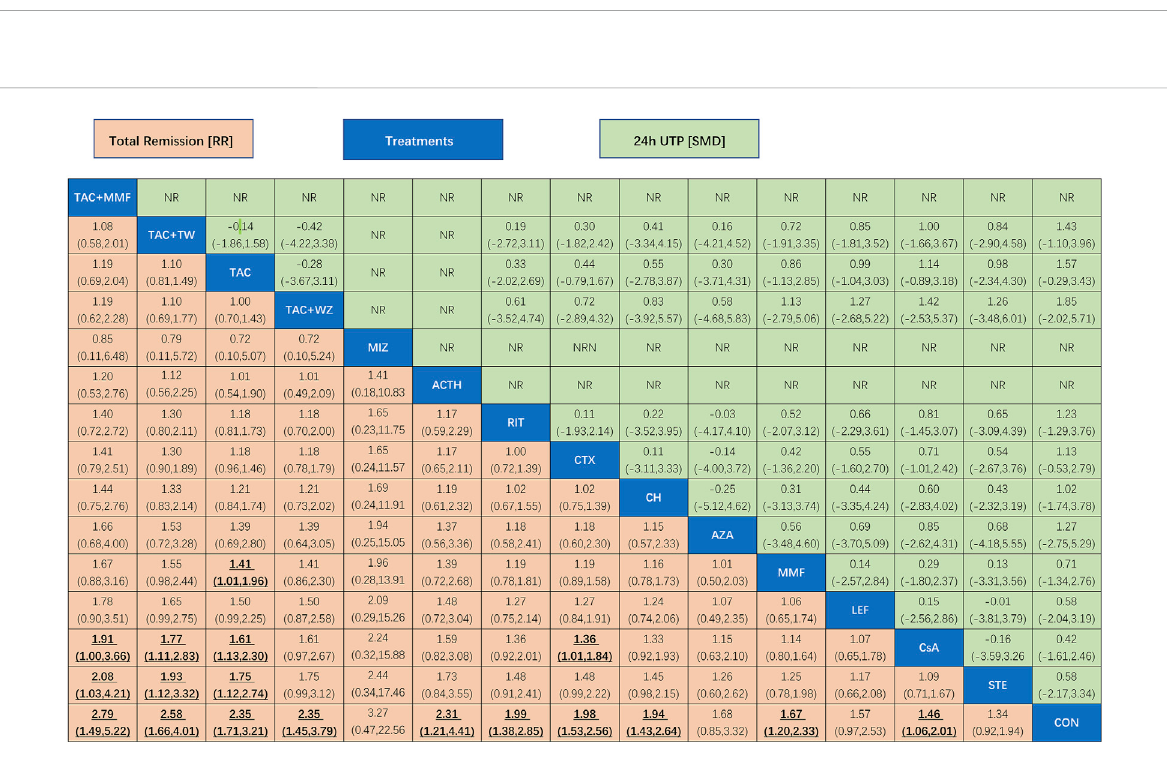
FIGURE 4 League table of all comparisons of total remission and 24-h UTP. Data are RRs (95% CI) for total remission (lower-left quadrant) and MDs (95% CI)for24-hUTP(upper-rightquadrant)inthecolumn-de fi ningtreatmentcomparedwiththerow-de fi ningtreatment.RRshigherthanonefavorthe column-de fi ning treatment and MDs lower than zero favor the row-de fi ning treatment. Signi fi cant results are in bold and underscored. ACTH, adrenocorticotropic hormone; AZA, azathioprine; CH, chlorambucil; CON, non-immunosuppressive therapies (the control group); CsA, cyclosporine; CTX, cyclophosphamide; LEF, le fl unomide; MMF, mycophenolate mofetil; MZB, mizoribine; RIT, rituximab; STE, steroids; TAC, tacrolimus; and TAC + MMF, tacrolimus combined mycophenolate